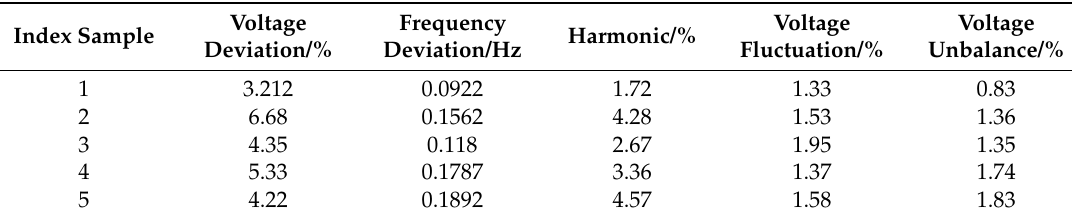
Table 8. The sample data of power quality indexes.